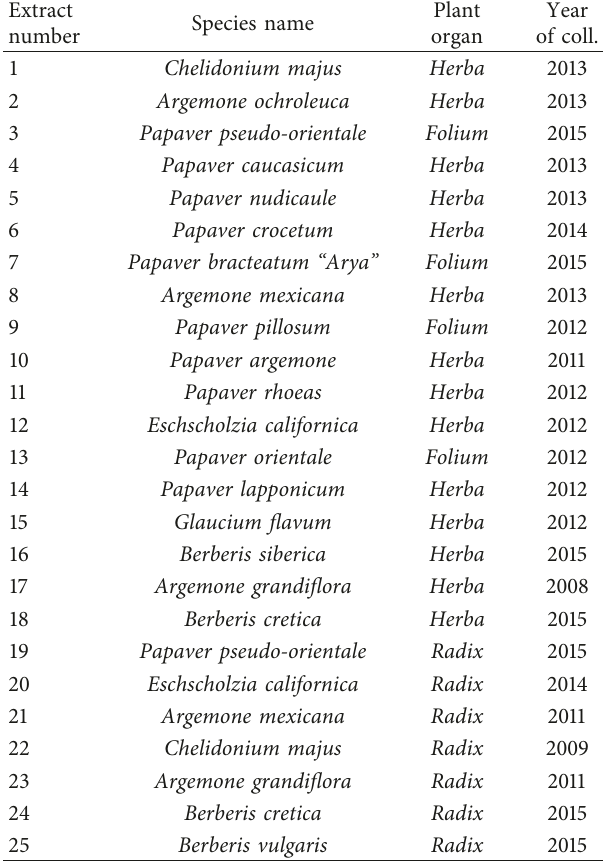
Table 1: A list of studied